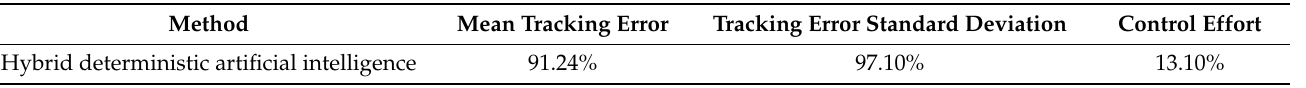
Table 9. Percent performance improvements in DAI vs Feedforward+Feedback for thirty degree yaw with perturbations and simulated damage 1 .